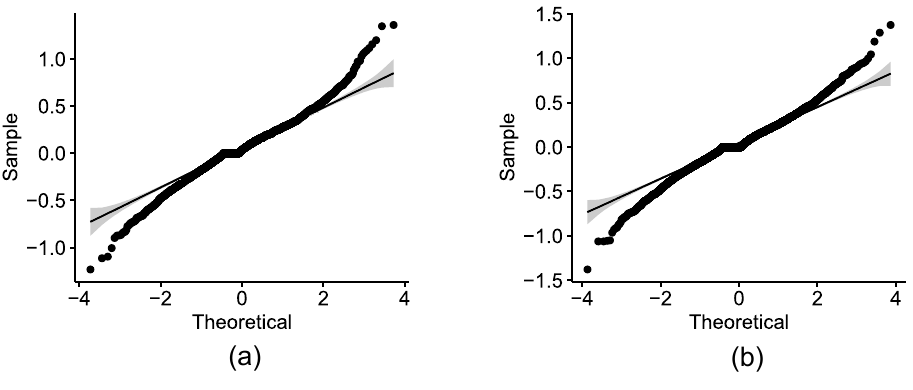
Figure 10. Q-Q plots. ( a ) February sample. ( b ) March